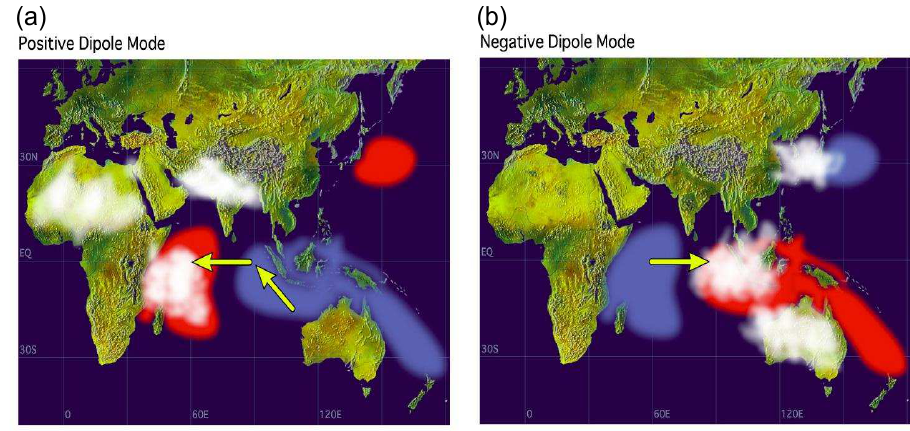
Fig. 1. (a) Normalized time series (mean zero and variance one) of IOD (from Japan Agency for Marine Earth Science and Technol- ogy ( http://www.jamstec.go.jp )) and ENSO (from KNMI Climate Explorer ( http://climexp.knmi.nl )) from 1900 to 1997 (b) Running correlation coefficients between IOD and ENSO for the past 10 years at all the time points. Both time series have been smoothed by using a 3-month moving average. The ENSO is represented by NINO3 sea temperature anomalies. By the red rect- angles the 1960’s is emphasized, where the IOD index obviously exhibits a behaviour different from that of ENSO in the 1960’s and